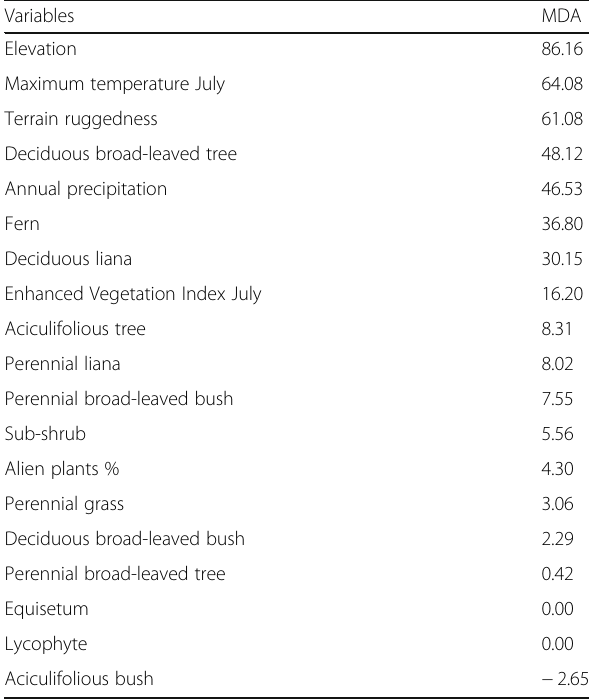
Table 4 Importance of the variables in the random forest model classification, showed as mean decrease accuracy (MDA; loss of model accuracy if the variable is excluded from the model, higher values indicate greater